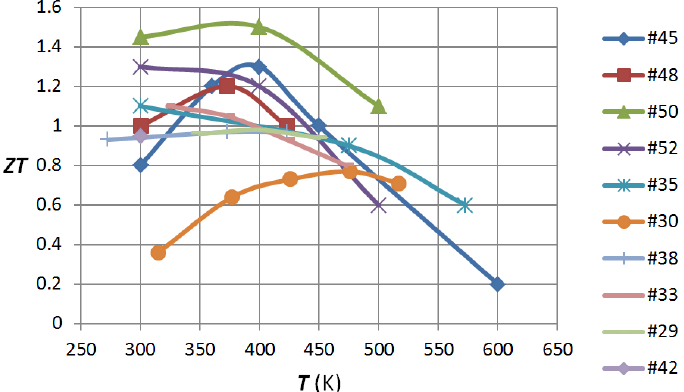
Figure 3. Plot of ZT against T for p-type bismuth telluride alloys. The sources of the values are the reference numbers as indicated.